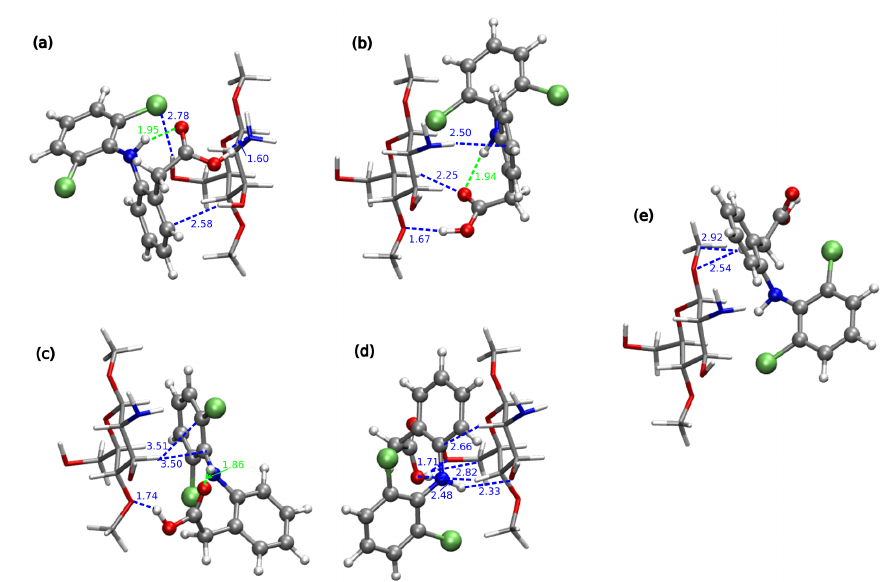
Figure 3. B97-D3/6-311++G(d,p) optimized most stable structures of chitozan unit interacting with DFH (explicite given the hydrogen–hydrogen-bond-acceptor distances and some other important contacts; blue for intermolecular contacts and green—for intramolecular): ( a ) CS1:DFH 6 , ( b ) CS1:DFH 9 , ( c ) CS1:DFH 4 , ( d ) CS1:DFH 2 and one with the weakest analyzed mutual attraction: ( e ) CS1:DFH 3 . DFH presented in Corey–Pauling–Koltun (CPK) representation and CS1—in licorice with following atom colors: chlorine—lime green, oxygen—red, nitrogen—cobalt blue, carbon—silver, hydrogen—white.